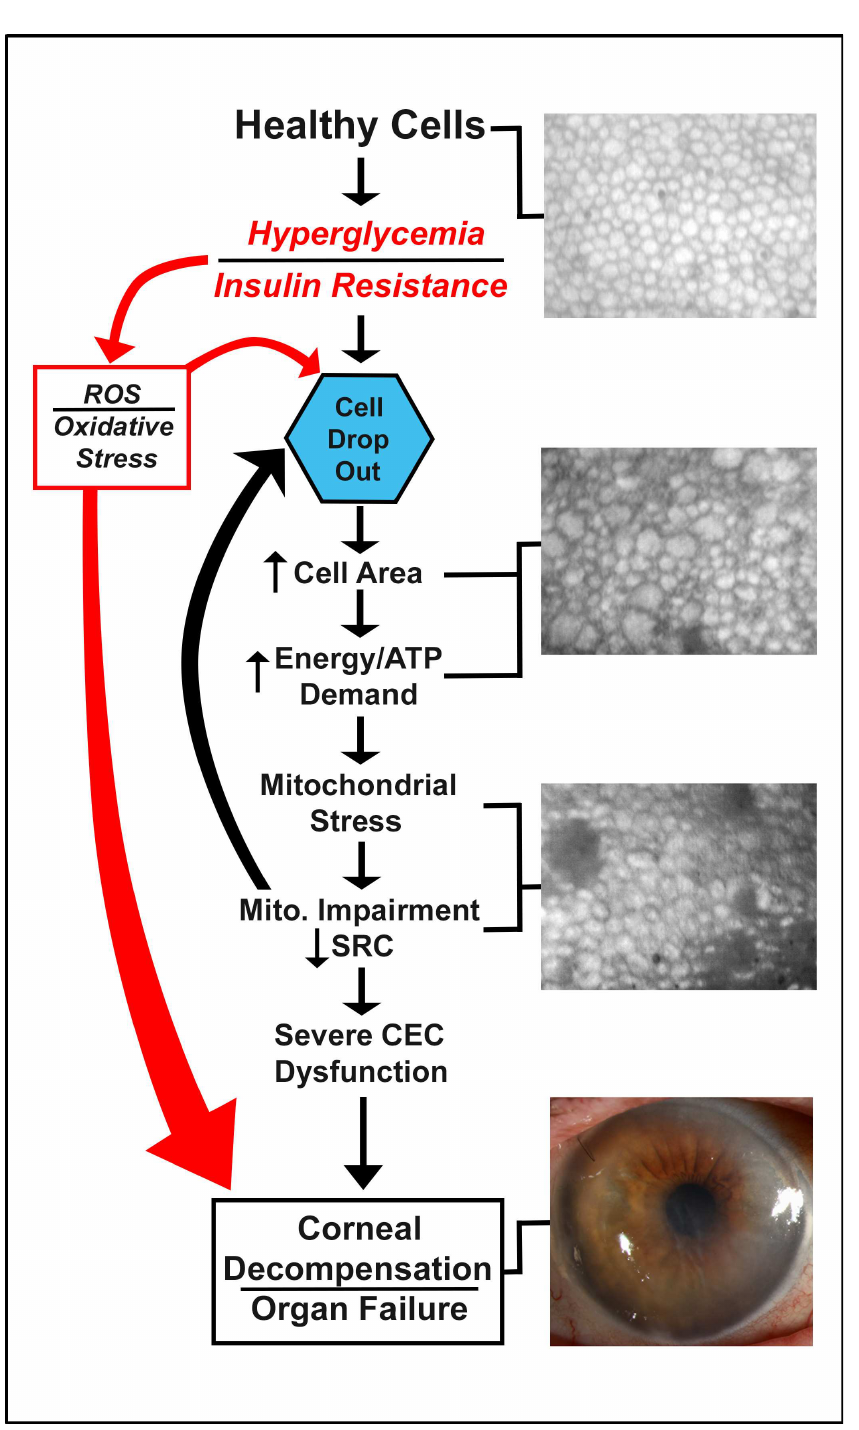
Fig 6. Hypothesis diagram. Hypothesis of how local hyperglycemia affects corneal endothelial cells (CECs) during the progression of T2DM. SRC, spare repiratory capacity as determined using extracellular flux analysis; ROS, reactive oxygen